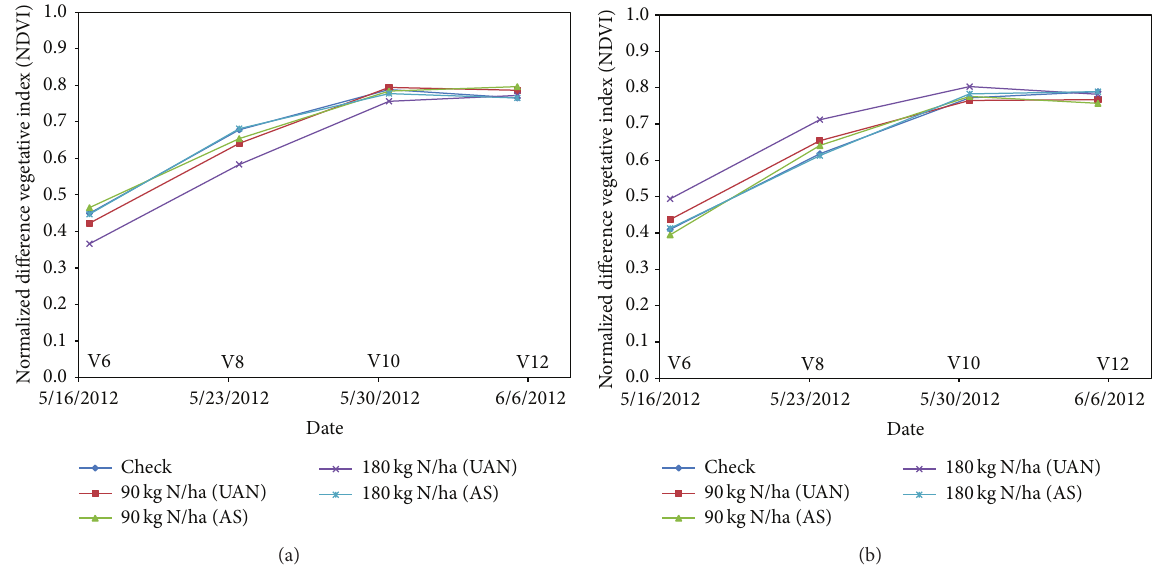
Figure 1: Normalized difference vegetative index (NDVI) values by maize growth stage for irrigated (a) and rain-fed (b) fertilizer treatments at Stillwater, OK (2012).